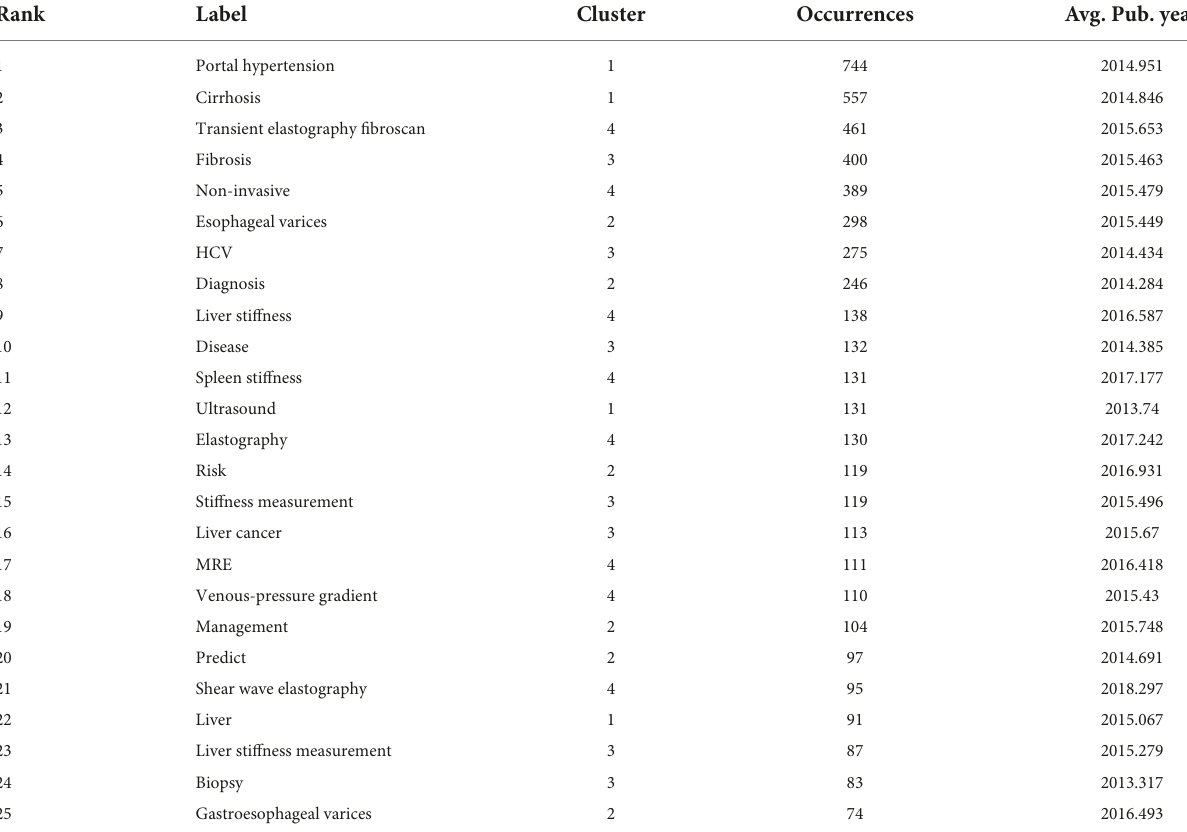
TABLE 7 Top 25 high-occurrence